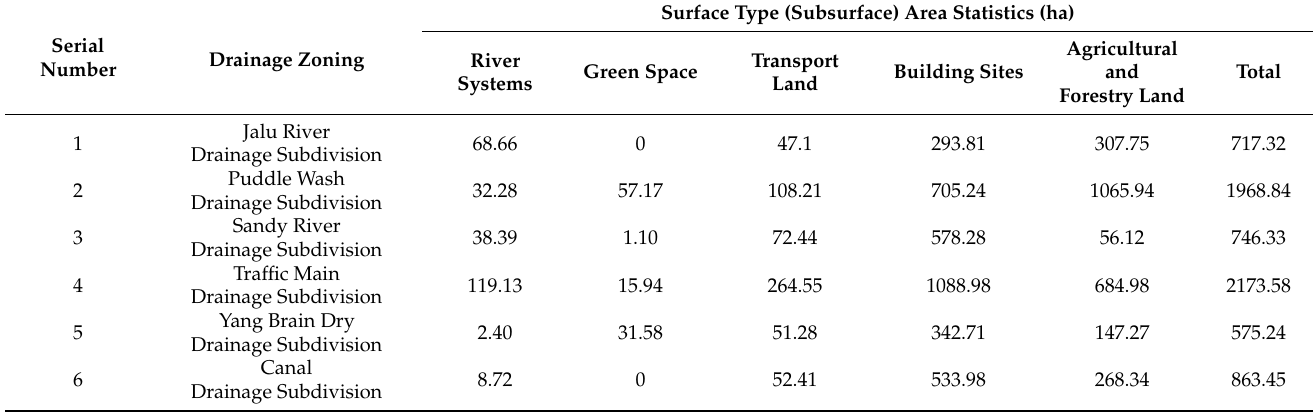
Table 1. Surface types (lower bedding surface) in the central city of